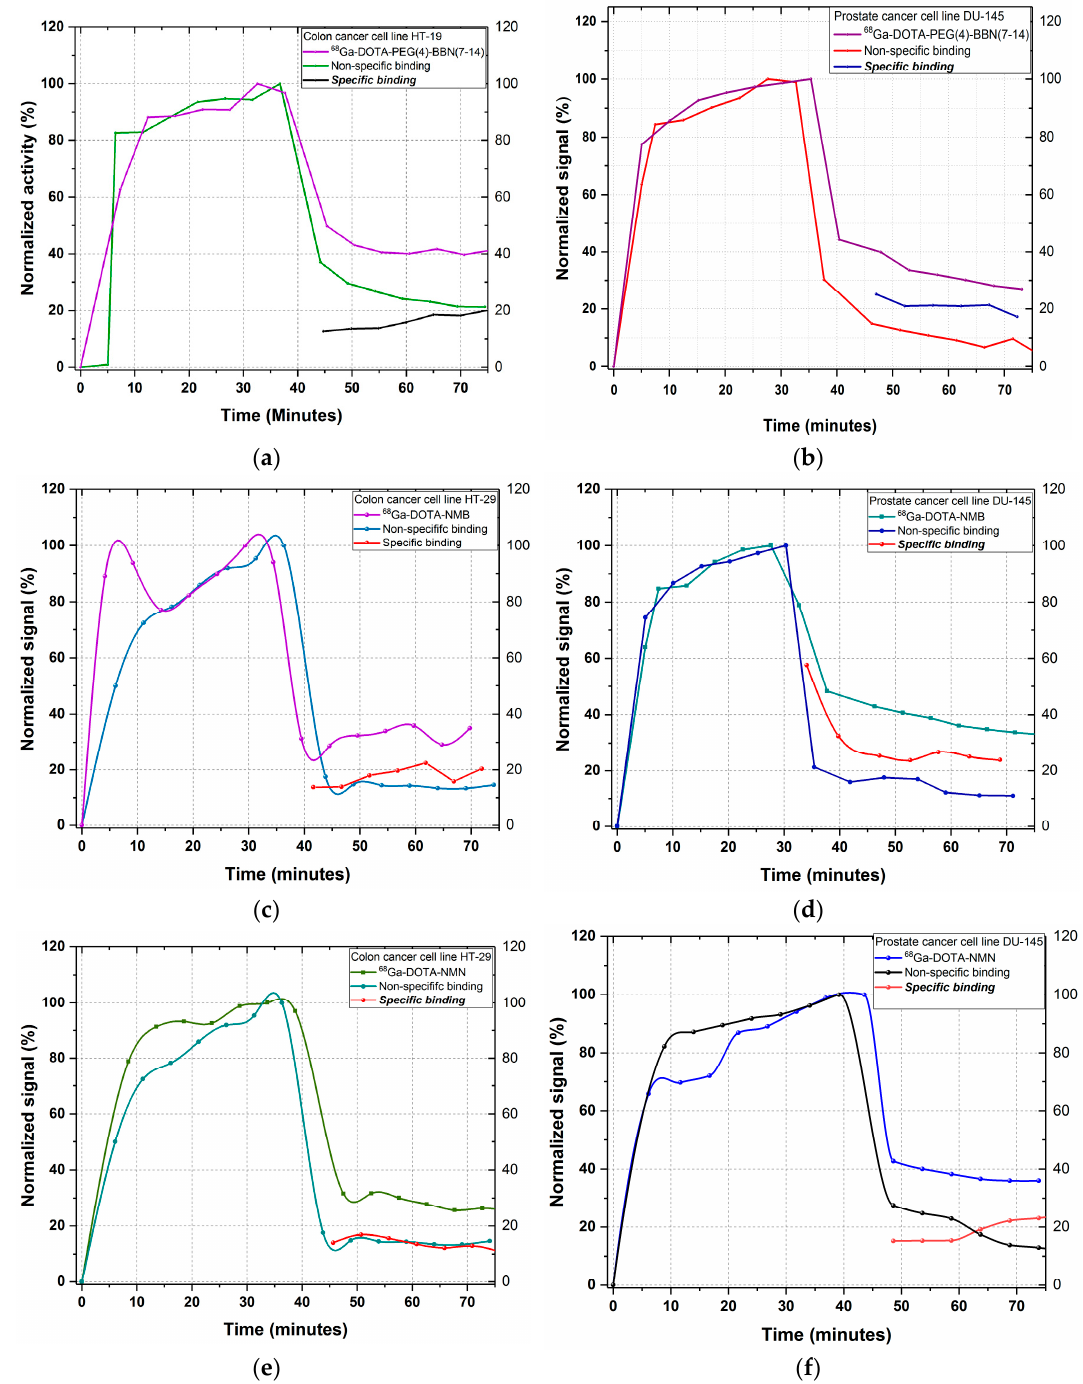
Figure 4. In vitro specific binding evaluation of: ( a ) 68 Ga ‐ DOTA ‐ PEG(4) ‐ BBN(7 ‐ 14) on HT ‐ 29 cell line; ( b ) 68 Ga ‐ DOTA ‐ PEG(4) ‐ BBN(7 ‐ 14) on DU ‐ 145 cell line; ( c ) 68 Ga ‐ DOTA ‐ NMB on HT ‐ 29 cell line; ( d ) 68 Ga ‐ DOTA ‐ NMB on DU ‐ 145 cell line; ( e ) 68 Ga ‐ DOTA ‐ NMN on HT ‐ 29 cell line; ( f ) 68 Ga ‐ DOTA ‐ NMN on DU ‐ 145 cell line.